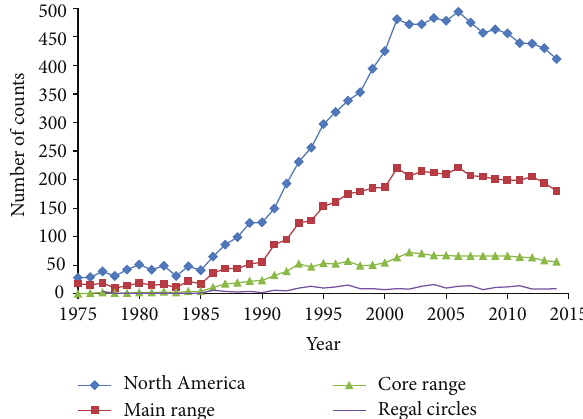
Figure 4: Number of counts per year in North America, main Regal range, core Regal range, and count circles ever reporting a Regal